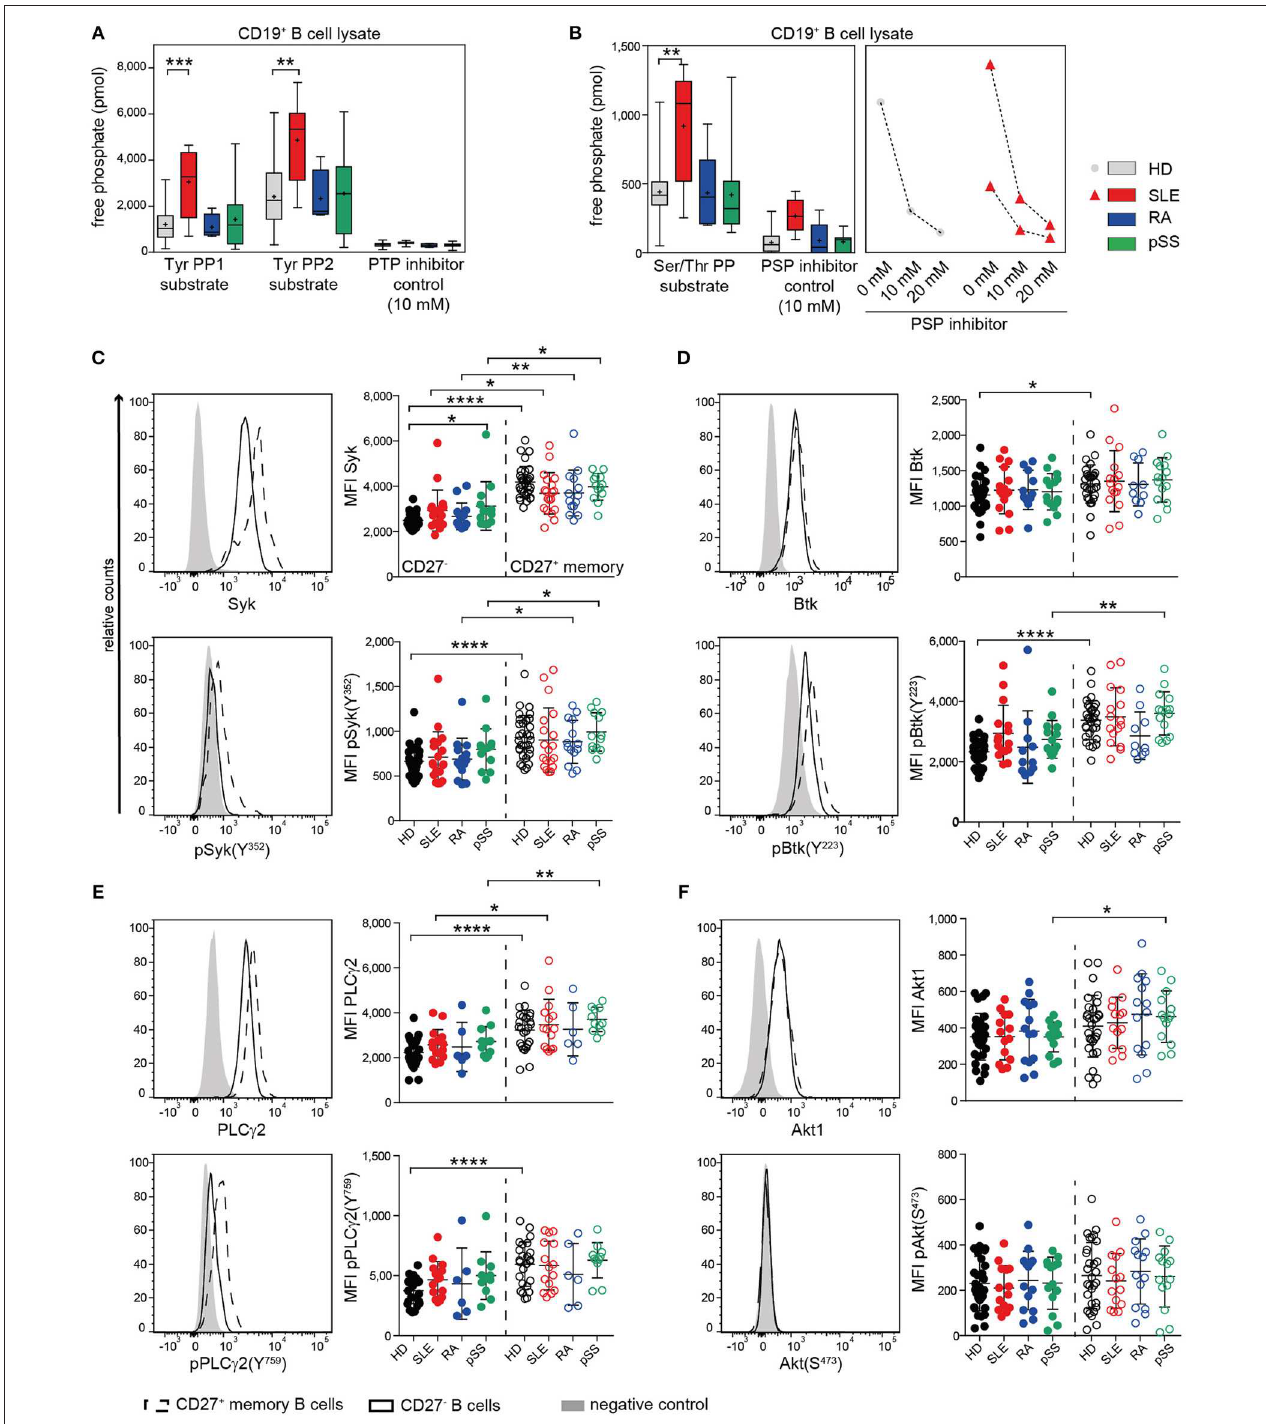
FIGURE 1 | Enhanced PTP activity in SLE B cells and similar kinase expression and phosphorylation in AID among CD27 − and CD27 + memory B cells. (A) PTP [n(HD/SLE/RA/pSS) = 22/8/4/13] and (B) PSP [n(HD/SLE/RA/pSS) = 19/8/5/10] activities of CD19 + B cells in HD (gray), SLE (red), RA (blue), and pSS (green). CD27 − (dots) and CD27 + memory (open circles) B cells from HD (black), SLE (red), RA (blue), and pSS (green) patients were analyzed for the expression of (C) Syk/pSyk(Y 352 ) [n(HD/SLE/RA/pSS) = 32/19/14/13]; (D) Btk/pBtk(Y 223 ) [n(HD/SLE/RA/pSS) = 30/16/11/15]; (E) PLC γ 2/pPLC γ 2(Y 759 ) [n(HD/SLE/RA/pSS) = 25/15/6/11] and (F) Akt1/pAkt(S 473 ) [n(HD/SLE/RA/pSS) 30/14/14/13]. Representative histograms of CD27 − (solid line); CD27 + (dashed line), and negative control (gray) are shown. Box whisker plots represent median (line), mean (plus), and the range from minimum to maximum; lines in scatter dot plots represent means ± SD (ANOVA with DMCT; t -test; * p ≤ 0.05, ** p ≤ 0.01, *** p ≤ 0.001, **** p ≤ 0.0001).